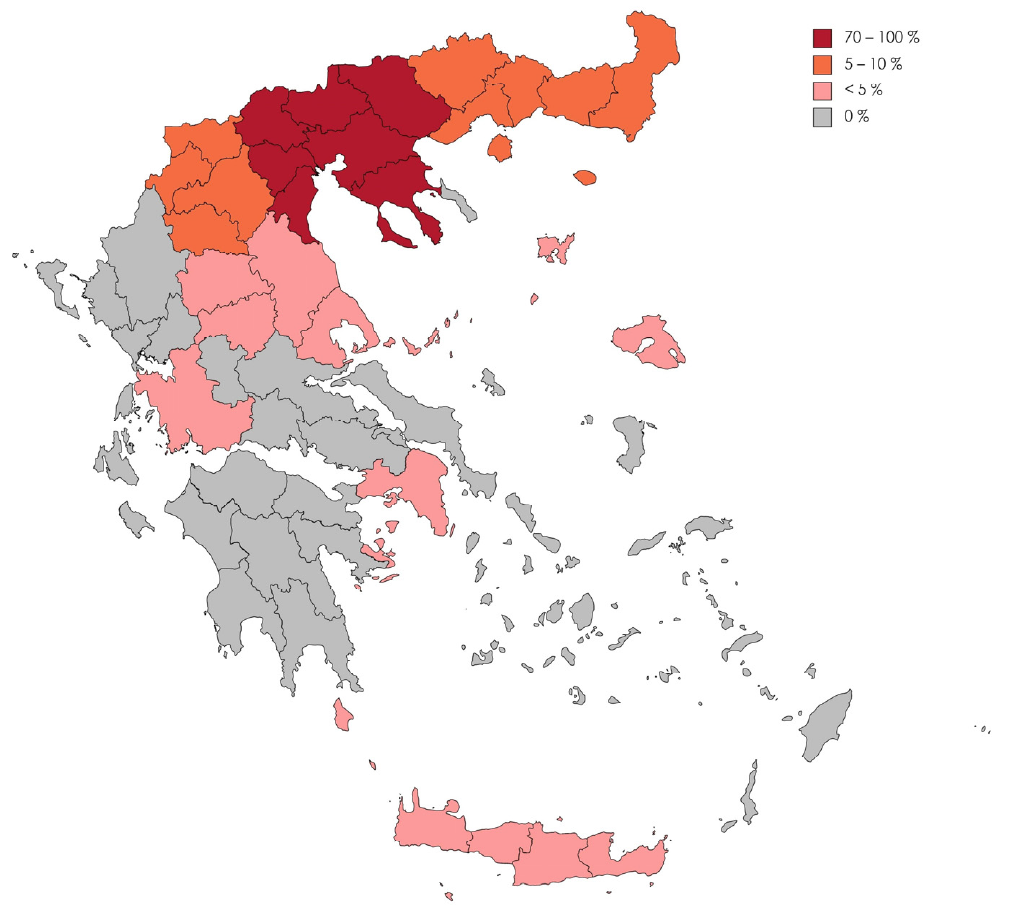
Figure 1. A map of Greece and the frequency of Rare Neurological Diseases admissions to the 2 nd Department of Neurology, AHEPA University Hospital of Thessaloniki, according to the geo- graphic regions of Greece.